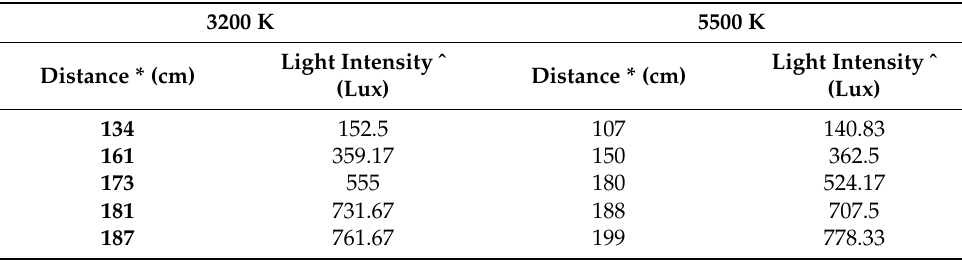
Table 2. Compare the relation among light intensity (Lux), light color (Kelvin), and detection distance (cm) for light source without diffuser.